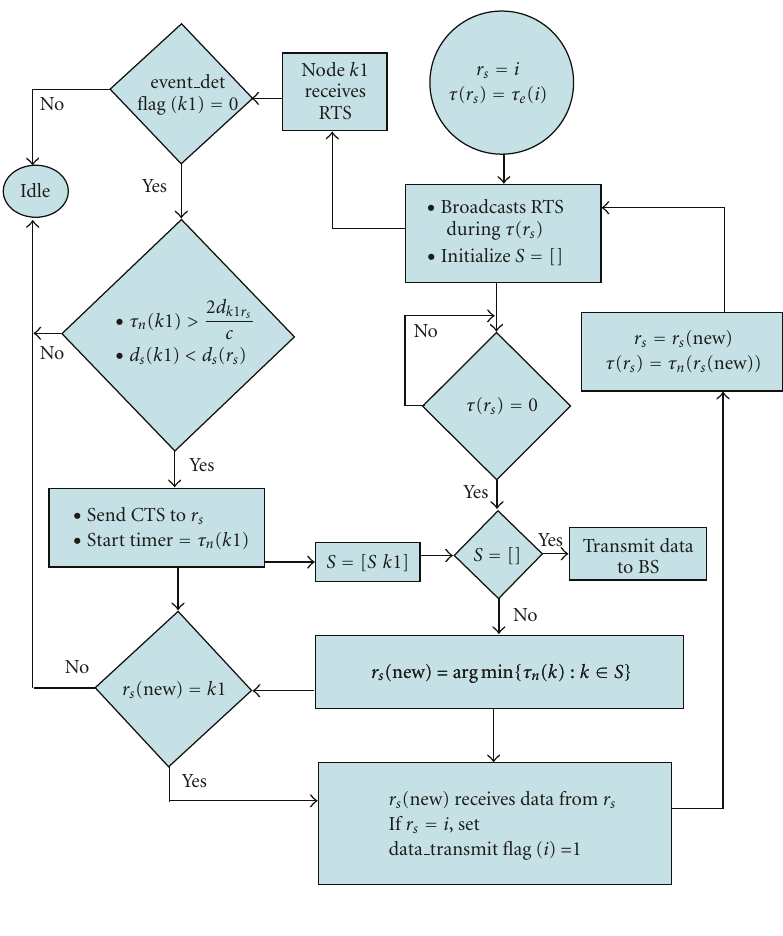
Figure 8: Flowchart of Routing in DVD.